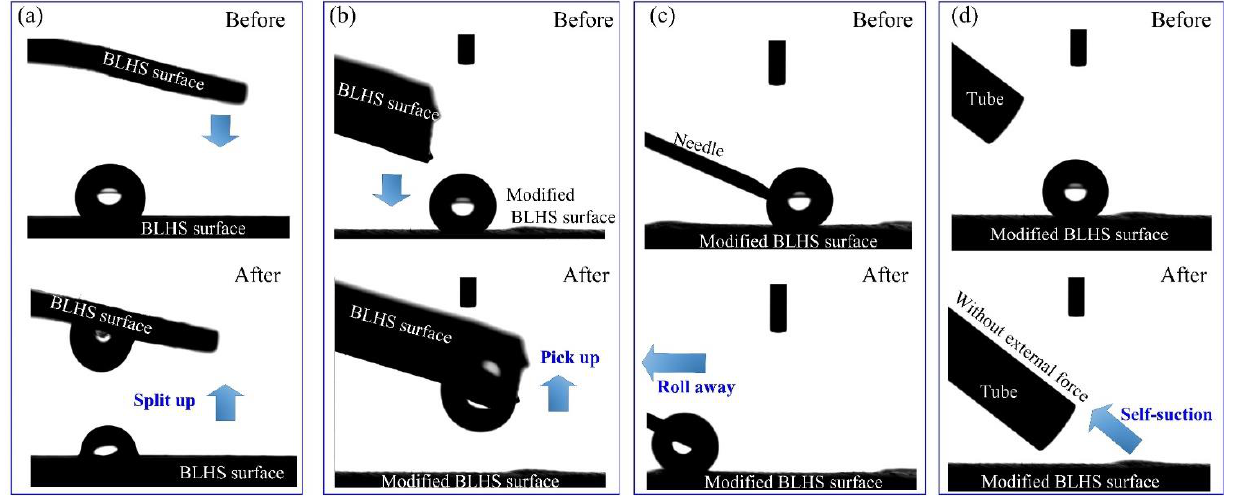
Figure 10. Droplet manipulation tests on ( a ) BLHS surface by a BLHS surface; ( b ) modified BLHS surface by a BLHS surface; ( c ) modified BLHS by a needle; and ( d ) modified BLHS surface by a tube.